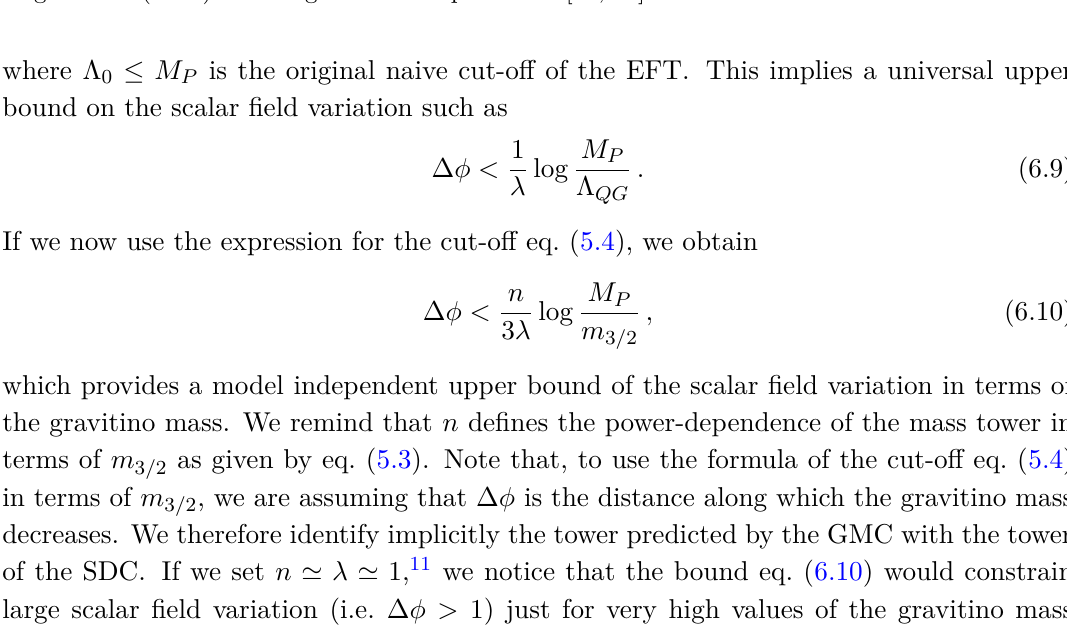
Figure 1 . Log-log plot of the lower bounds on the gravitino mass (in GeV) in terms of the tensor- to-scalar ratio measured at CMB scales, as given by eq. (6.5). The plot is given for n = { 2 / 3 , 1 , 2 , 3 } and the orange line corresponds to the predictions of the strong GMC. The red vertical line shows the upper bound r . 0 . 06 set by Planck [93] while the green vertical area corresponds to the future target r = O (10 − 3 ) of next-generation experiments [35,